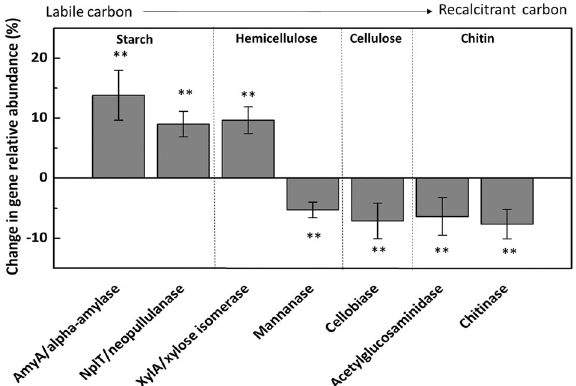
Fig. 1 The warming effect on carbon (C) degradation genes. The complexity of C is arranged in the order from labile to recalcitrant. Mean abundances of C degradation genes are compared between warmed and control samples, which were calculated as (warming − control)/control × 100%. Error bars represent standard error ( n = 4). The differences between warming and control were